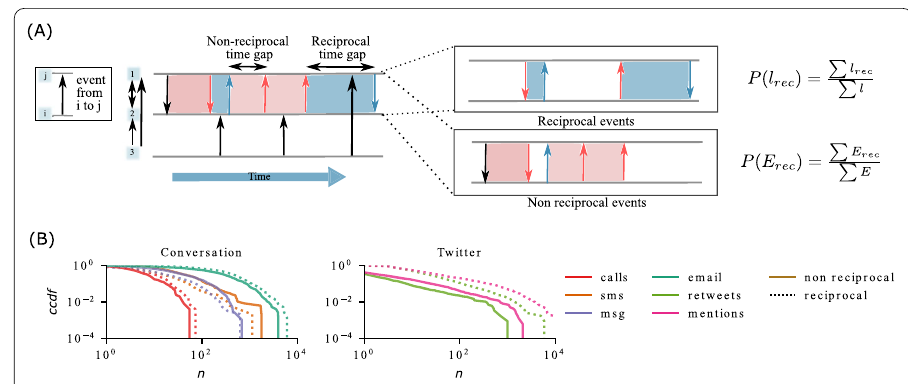
Figure 1 Reciprocal and non-reciprocal activity in empirical communication networks. (top) Schema for separating a temporal network of time-stamped, directed communication events between pairs of individuals (black arrows, left) into reciprocal and non-reciprocal components (right). A pair of consecutive events is a reciprocation if events have the opposite direction (blue areas), and a non-reciprocation if they have the same direction (red areas). (Non-) reciprocal time gaps are then the inter-event times within (non-) reciprocations (see Additional file 1 Section S1). (bottom) Complementary cumulative distribution function P ( n (cid:3) > n ) (ccdf), the fraction of nodes having strictly more than n reciprocations (solid) or non-reciprocations (dashed) in various communication channels. one-to-one communication channels tend to be more reciprocal than broadcasting channels (i.e. Twitter; see Table 1)